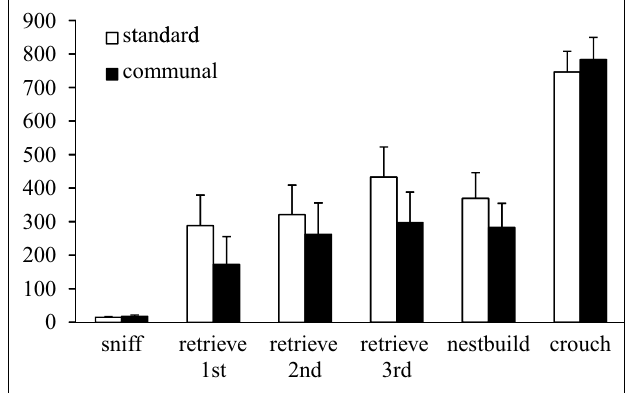
FIGURE 4 | Behavior of F2 females from standard vs. communal rearing conditions during a test of pup retrieval. No signifi cant differences were observed between groups in any